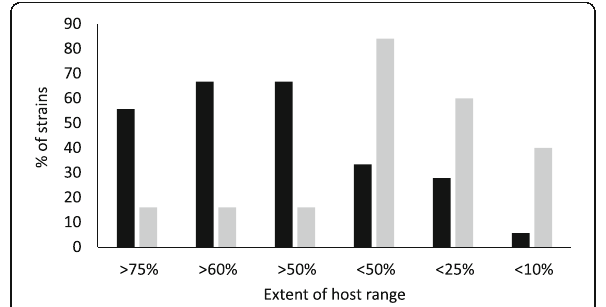
Fig. 6 The extent of host range in strains of Pseudomonas syringae that displayed swarming by 27h on a nutrient medium (black bars) compared to those that did not display swarming by 48h (grey